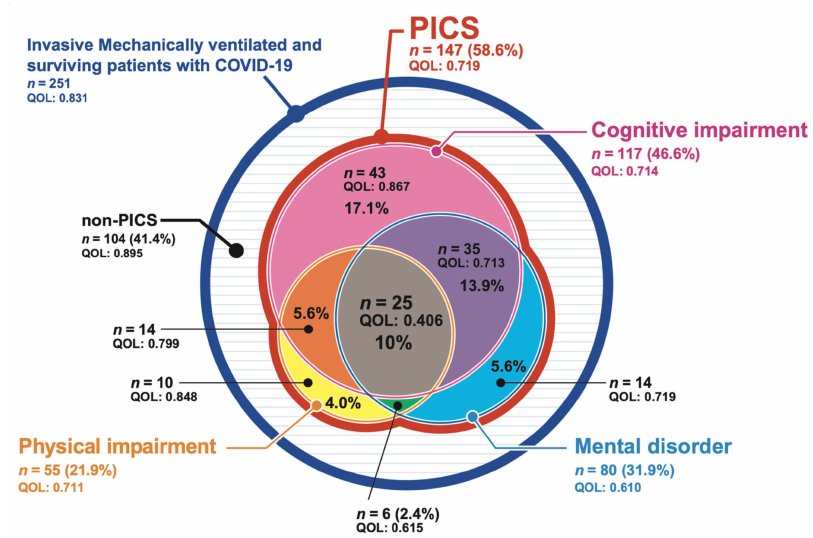
Figure 2. The prevalence of post-intensive care syndrome (PICS) after intensive care unit (ICU) discharge on the first PICS survey. The details of the prevalence of PICS, as well as the EQ-5D-5L values for each, among patients with coronavirus disease 2019 (COVID-19) who required ventilatory management during admission. EQ-5D-5L values are expressed as quality of life. PICS: post-intensive care syndrome; QOL: quality of life.